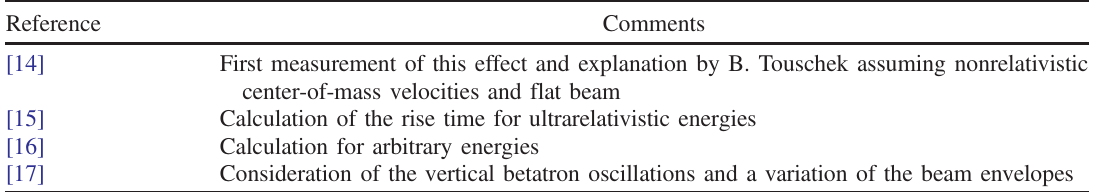
TABLE II. Historical notes for the Touschek effect.